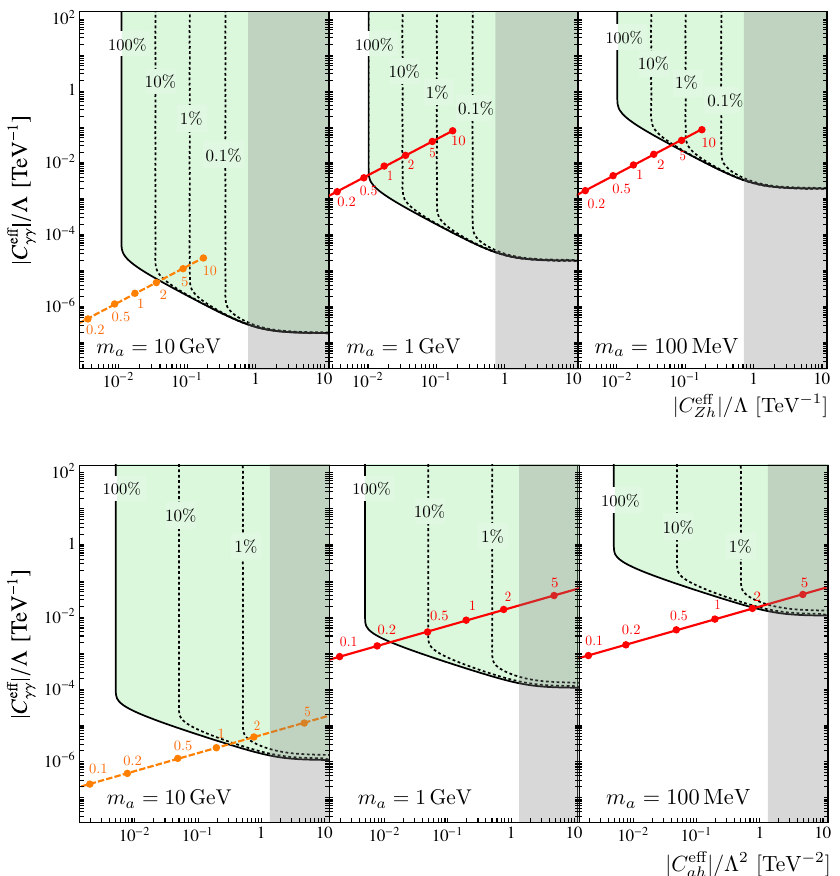
Figure 18 . Parameter space in the plane of the ALP-photon and ALP-Higgs couplings (green regions to the right of the black contours) for which at least 100 events are produced in the h Za ‘ + ‘ (cid:0) (cid:13)(cid:13) (top) and h aa 4 (cid:13) (bottom) search channels at the LHC Run-2 with 300 fb (cid:0) 1 ! ! ! and for m a = 10 GeV, 1 GeV and 100 MeV. The contours correspond to Br( a and 0.1, 0.01, 0.001 (dotted), as indicated. The gray areas indicate the regions excluded by the bounds (5.11) and (5.16). The colored lines show the values of the Wilson coe(cid:14)cients in two speci(cid:12)c scenarios, in which the ALP-boson couplings are induced by loops of SM quarks (see text for more